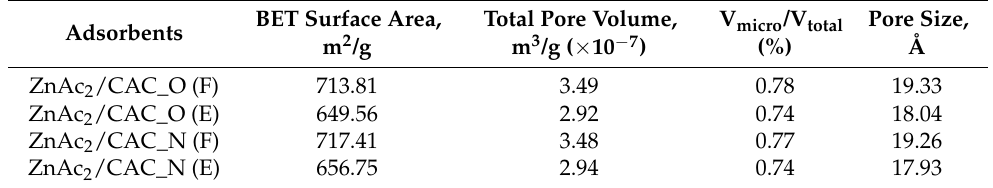
Table 11. Porous properties for regeneration of optimized and non-optimized adsorbents. BET Surface Adsorbents